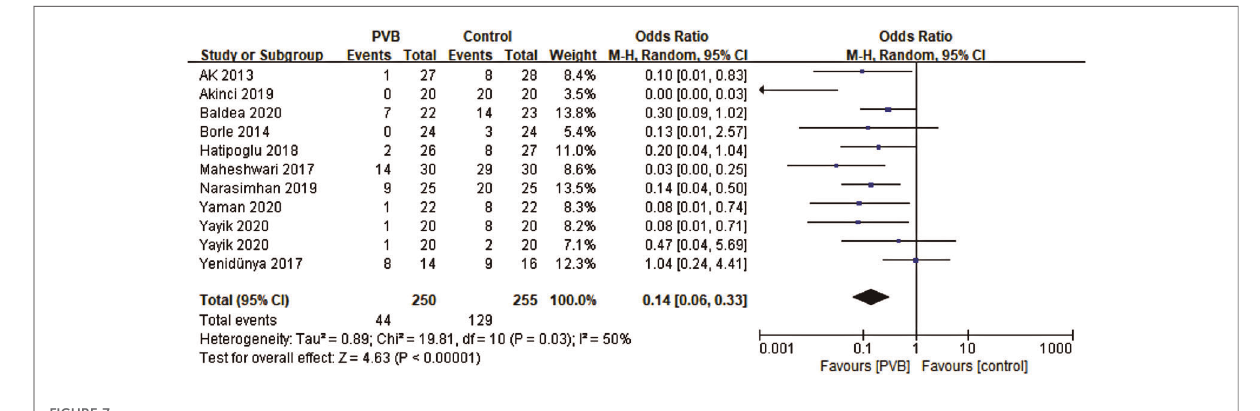
FIGURE 7 Forest plot of the incidence of postoperative additional